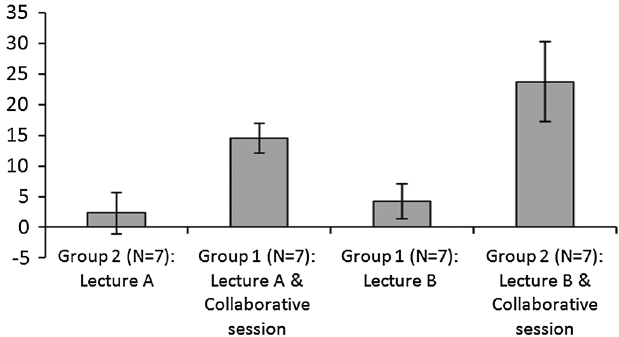
FIG. 3. Long-term retention of content. Average post-delayed test scores relative to the average corresponding pretest scores in the different experimental conditions.